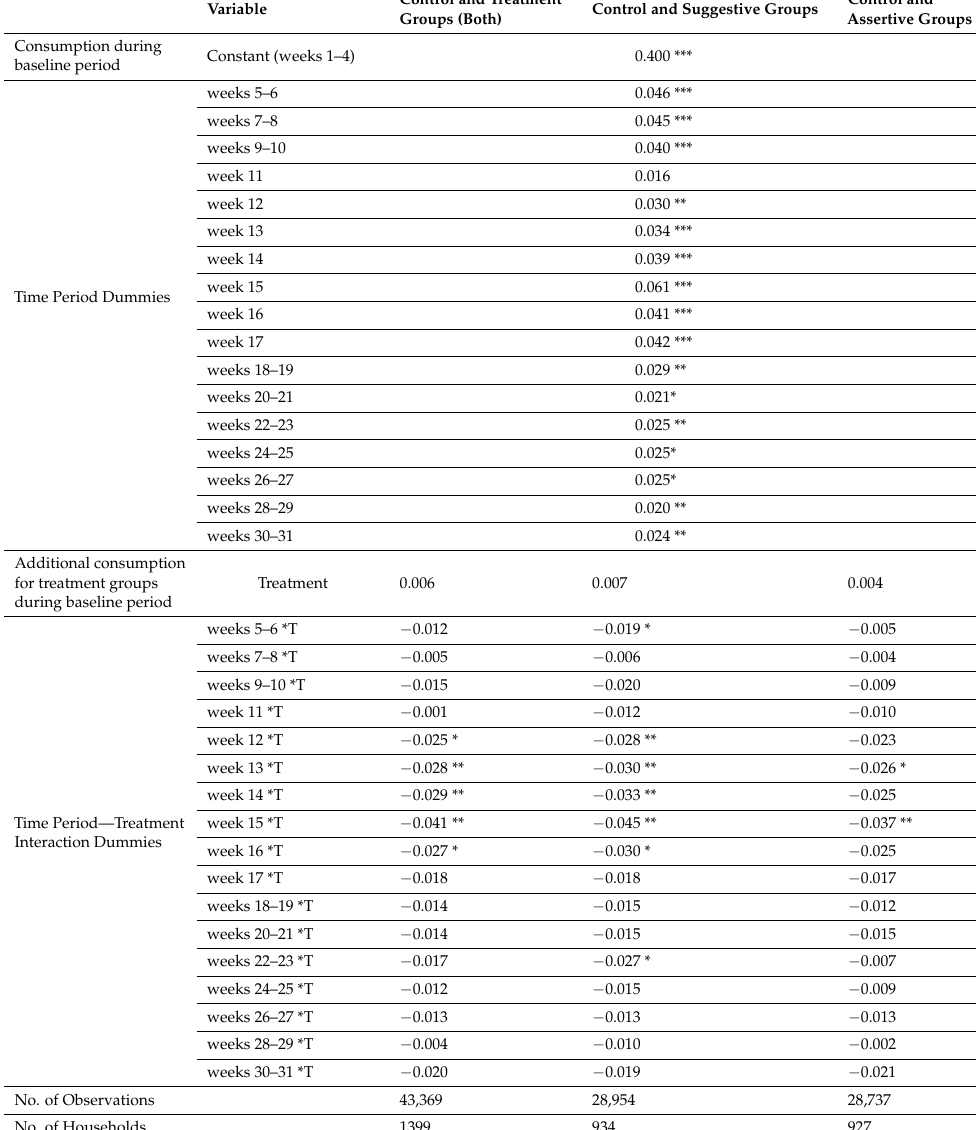
Table 1. Regression results for mean daily consumption (m 3